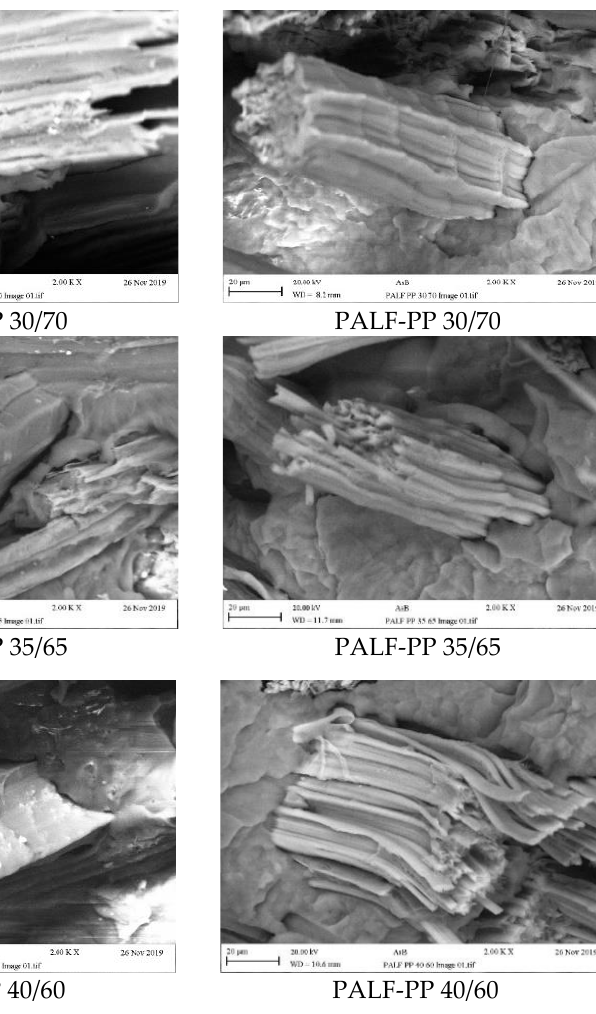
Figure 13. Close view of fiber matrix interaction in all the composites.